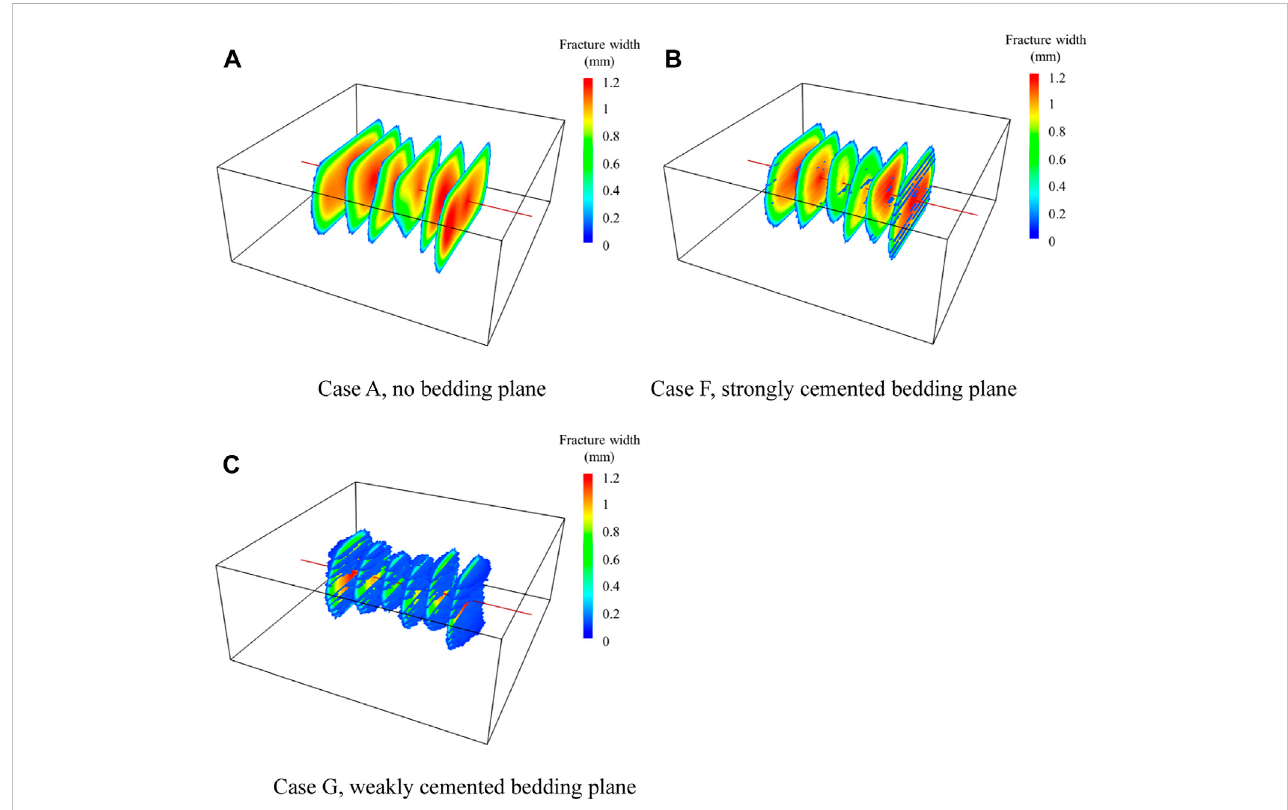
FIGURE 6 Fracture morphology for three cases with different bedding development level. (A) Case A, no bedding plane. (B) Case F, strongly cemented bedding plane. (C) Case G, weakly cemented bedding